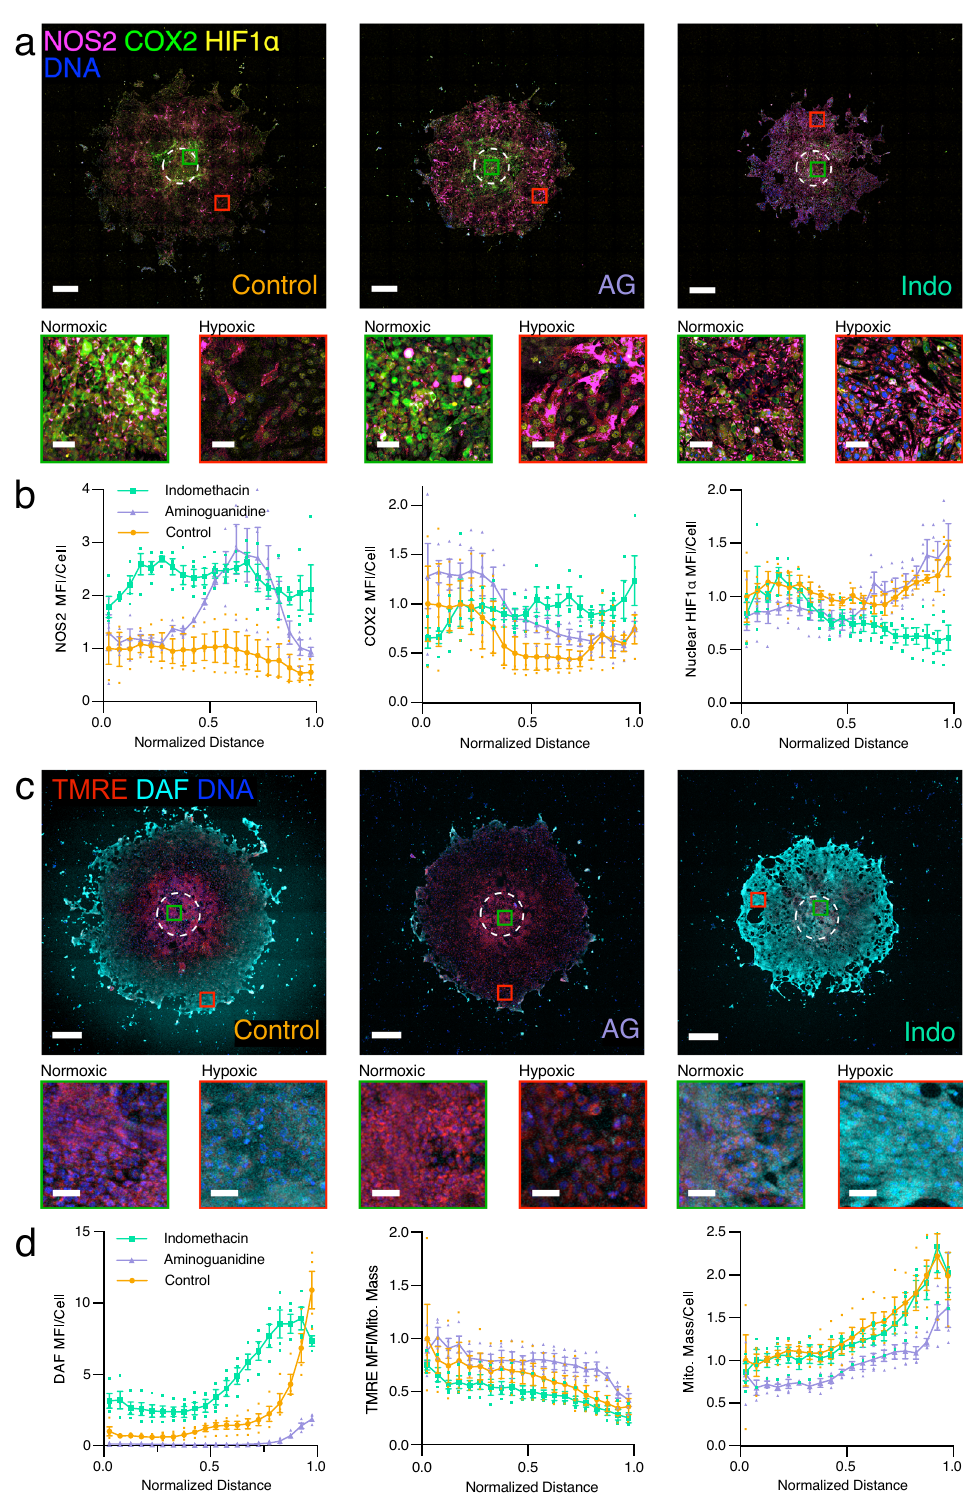
Fig. 4 Effects of NOS2 inhibition by aminoguanidine (AG, 1 mM) or COX2 inhibition by indomethacin (Indo, 100 µ M) on 4T1 phenotype along hypoxic gradients. a Spatial distribution of NOS2, COX2, and HIF1 α imaged by wide fi eld immuno fl uorescence microscopy of 7-day old untreated 4T1 disks (control), AG-treated disks, and Indo-treated disks. b NOS2, COX2, and HIF1 α distributions in 7-day old untreated 4T1 disks (control, N = 3), AG-treated disks ( N = 4 for NOS2, COX2, and HIF1 α ), and Indo-treated disks ( N = 4). c Spatial distribution of DAF and TMRE fl uorescence imaged by confocal microscopy of 7-day old untreated 4T1 disks (control), AG-treated disks, and Indo-treated disks. d DAF, TMRE, and ATP5A distributions in 7-day old untreated 4T1 disks (control, N = 4), AG-treated disks ( N = 4), and Indo-treated disks ( N = 4). “ Normalized Distance ” refers to the relative distance from the center to the edge of a disk. MFI mean fl uorescence intensity normalized to the fi rst point of the untreated control. Magni fi ed areas of normoxic (green squares) and hypoxic (red squares) cells are displayed below each image. Scale bars = 500 µ m, inset scale bars = 50 µ m. Data plotted as mean ±